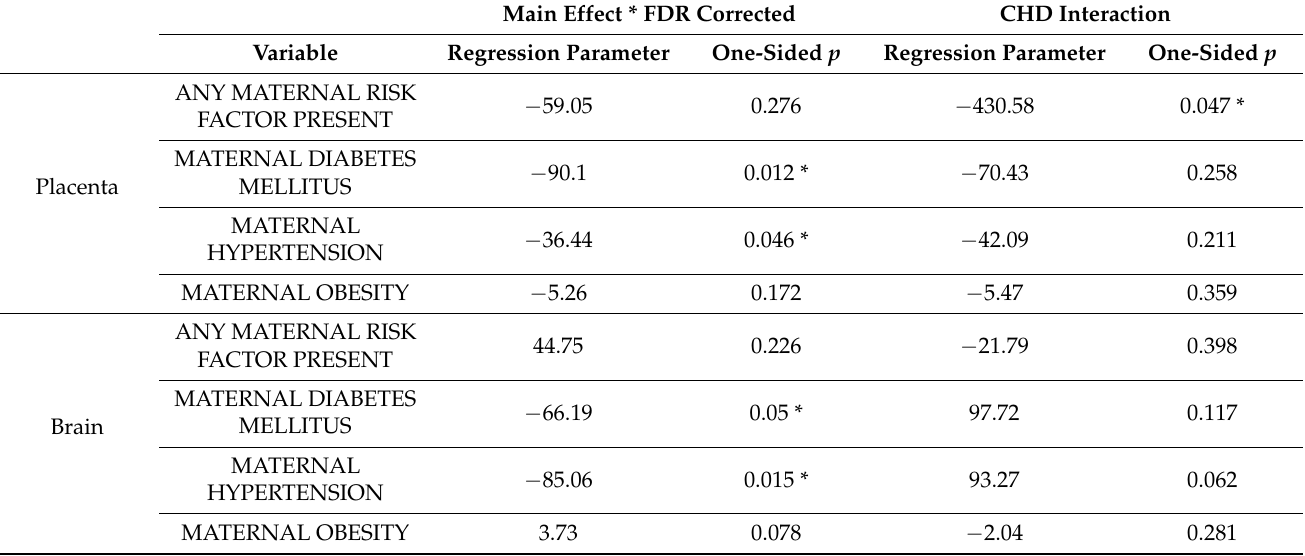
Table 4. Association between Maternal Risk Factors (MRF) and Temporal Variance in CHD and Non-CHD Group.